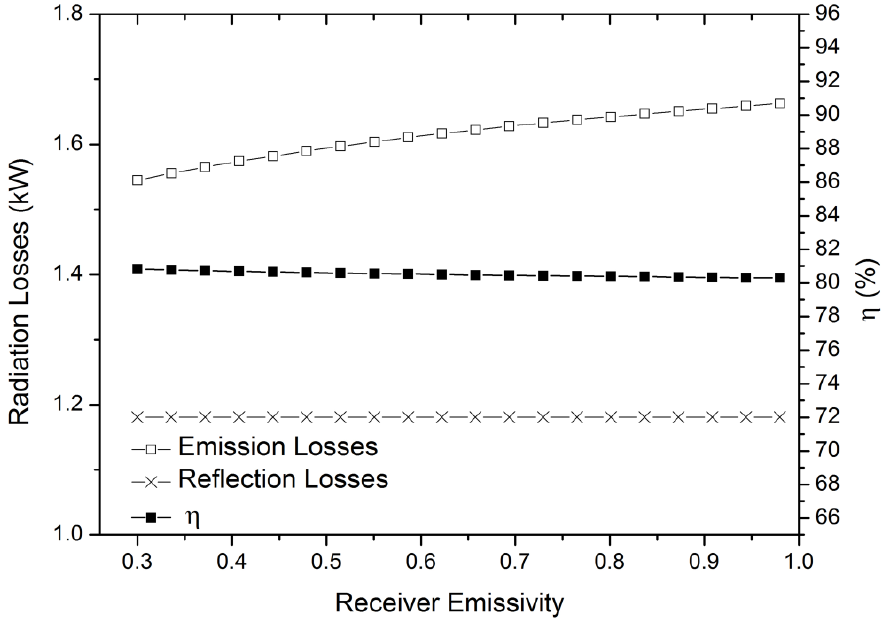
Figure 14. Efficiency and radiation losses varying receiver emissivity (solar source: 28